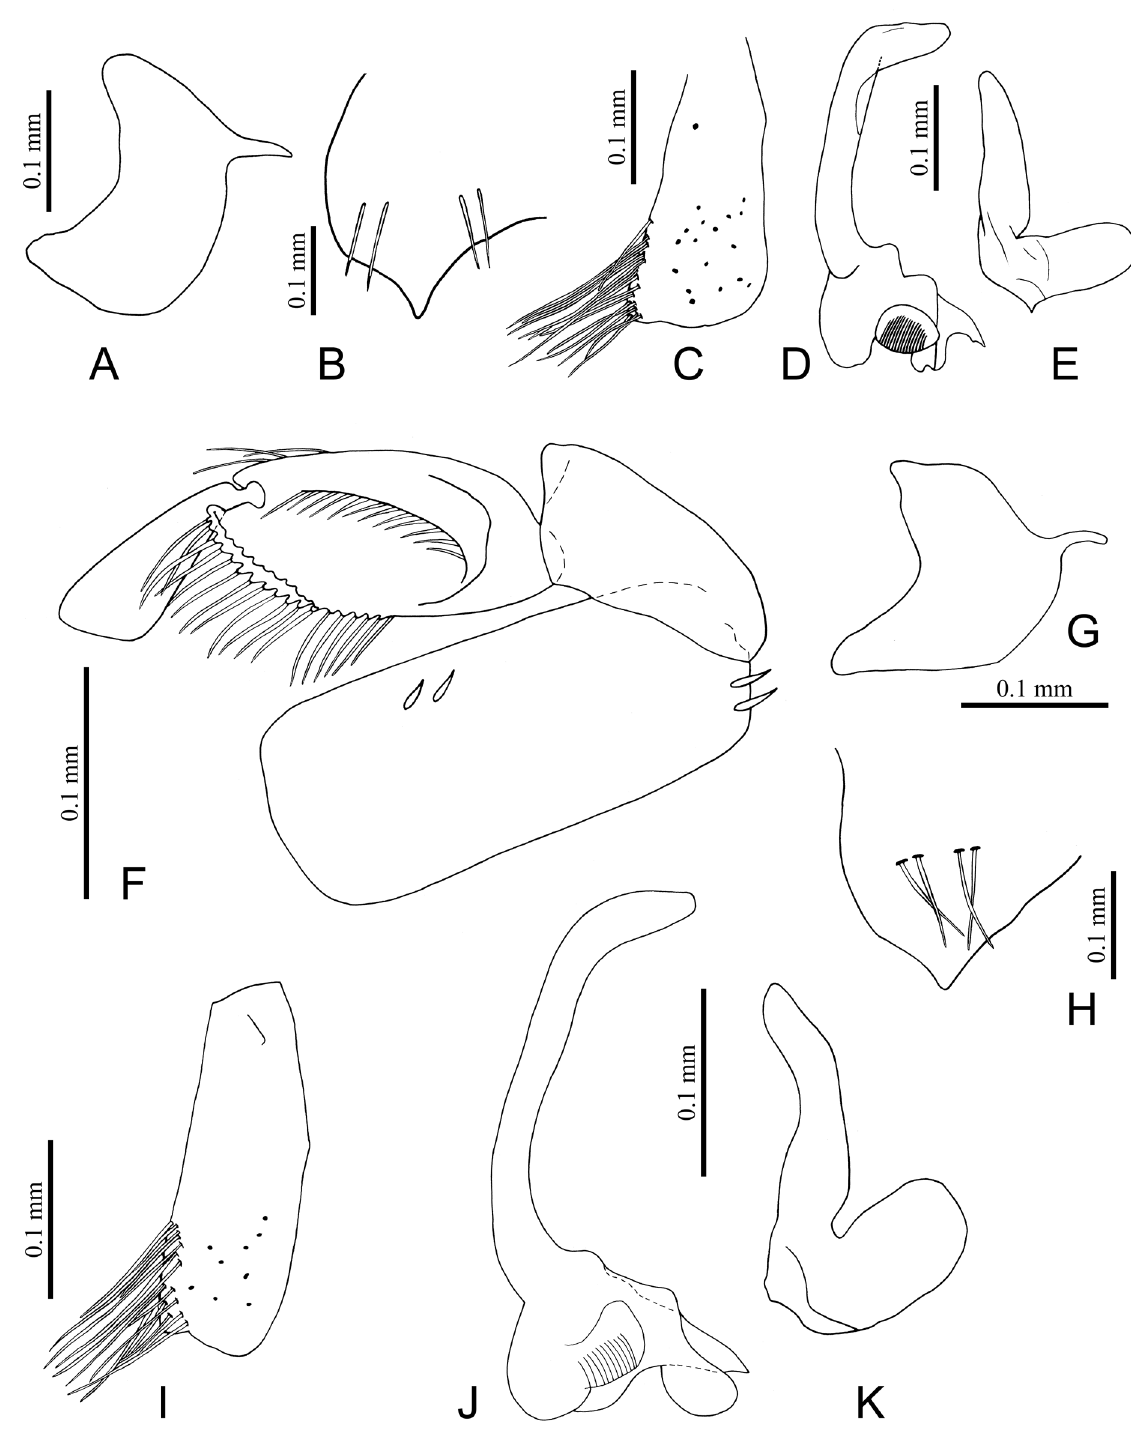
Fig. 9. Morphological features of species of Micronecta Kirkaldy, 1897, ♂♂. A–E . M. anatolica Lindberg, 1922 (ZVNU). F–K . M. arcuata sp. nov., paratype (ZVNU). A, G = prestrigilar flap; B, H = median lobe of sternite VII; C, I = free lobe; D, J = right paramere; E, K = left paramere; F = fore